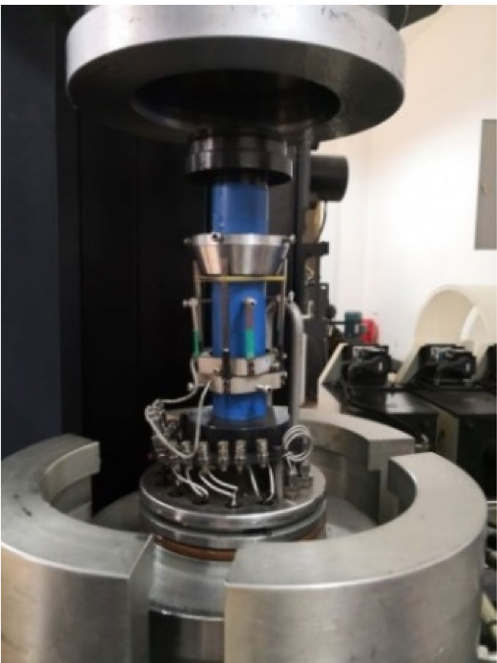
Figure 3. Sample installation diagram.